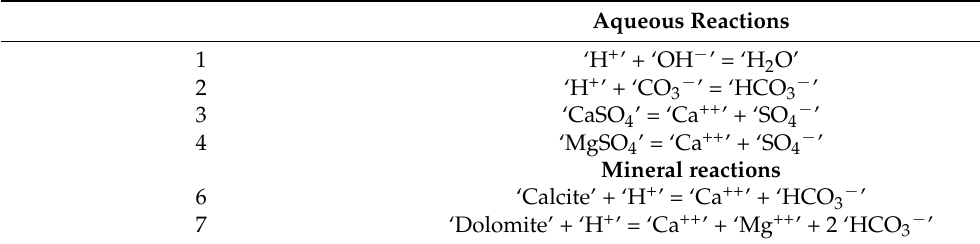
Table 3. Geochemical reactions used in modeling low-salinity waterflooding using CMG’s GEM